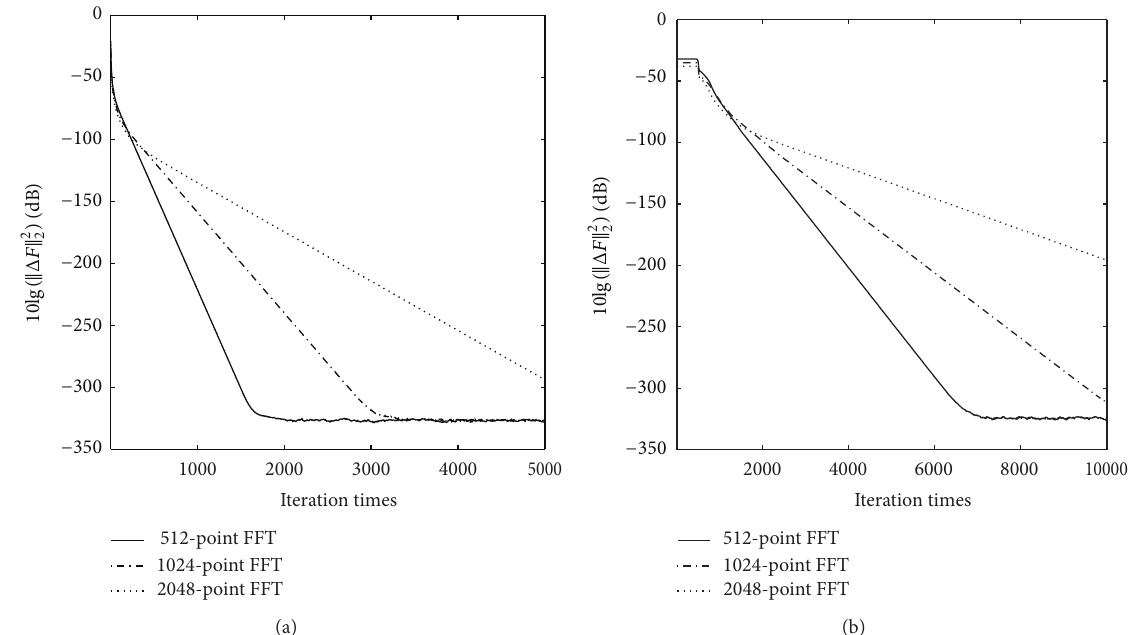
Figure 2: Norm of the error pattern: (a) amplitude-only and (b) phase-only.